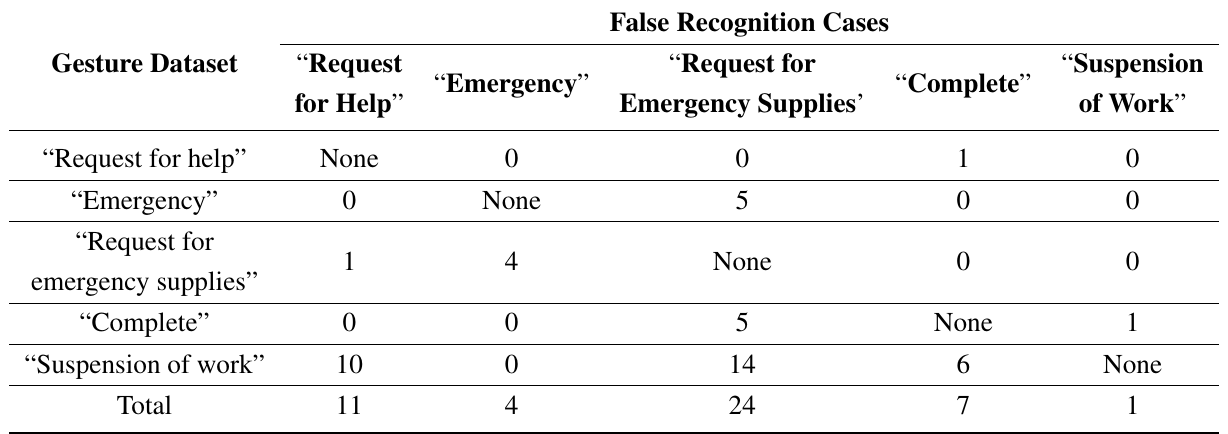
Table 6. False gesture recognition